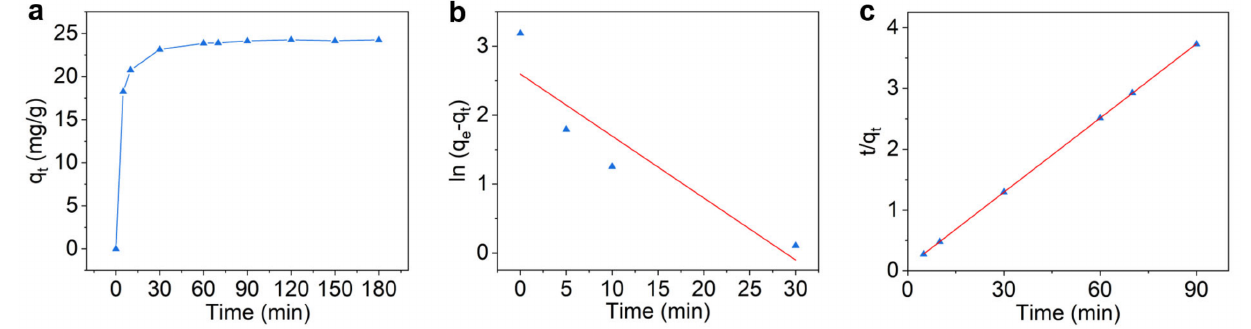
Figure 5. ( a ) Time-dependent RhB (10 mg/L) adsorption by 20 mg BOI 2 /BMO. ( b ) Pseudo-first-order kinetics and ( c ) pseudo-second-order kinetics